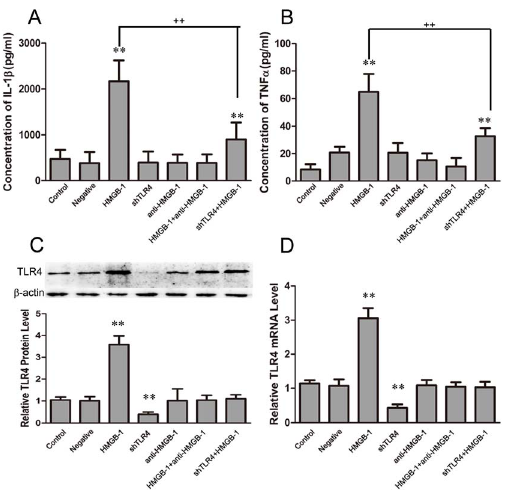
Figure 5. The effect of TLR4 inhibition on the inflammatory response by HMGB-1-treated NR8383 cells. RNAi was used to inhibit TLR4 expression in NR8383 cells. The levels of IL-1 b and TNF- a in the culture supernatants were determined by ELISA after transfection and 24 h after HMGB-1 administration. The levels of IL-1 b and TNF- a in negative, shTLR4, and anti-HMGB-1 groups were comparable to the control group. After treatment with HMGB-1, the IL-1 b and TNF- a concentrations in the HMGB-1 group were higher than those in the shTLR4 + HMGB-1 group, while there were no changes in these concentrations in the HMGB-1 + anti-HMGB-1 group (A, B). The expression of TLR4 was assessed by western lot and real-time quantitative PCR after transfection and 24 h after HMGB-1 administra- tion. After transfection, The TLR4 protein and mRNA levels were very low in the shTLR4 group, decreasing by approximately 60%. After treatment with HMGB-1, the levels of TLR4 protein and mRNA in the shTLR4 + HMGB-1 group returned to the levels of the control. In addition, the levels of TLR4 protein and mRNA remained the same in the anti- HMGB-1 and HMGB-1 + anti-HMGB-1 groups (C, D). Data are shown as the mean 6 SD, n=6, ** P , 0.01 vs. control, ++ P , 0.01 vs. shNT + HMGB-1.